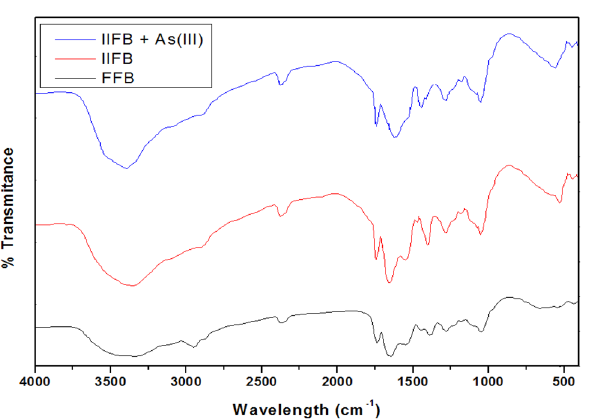
disc. ( c ) SEM image showing luffa sponge fiber. ( d ) SEM image of FFB (in inset) and spectra of its EDX analysis. ( e ) SEM image of IIFB (in inset) and corresponding EDX analysis before As(III) biosorption. ( f ) SEM image of IIFB (in inset) and corresponding EDX analysis after As(III) biosorption.